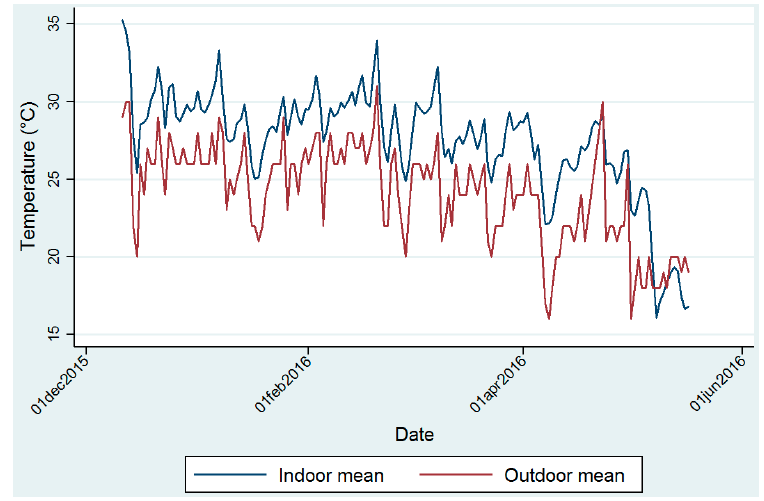
Figure 2. Daily mean indoorand outdoor temperatures.